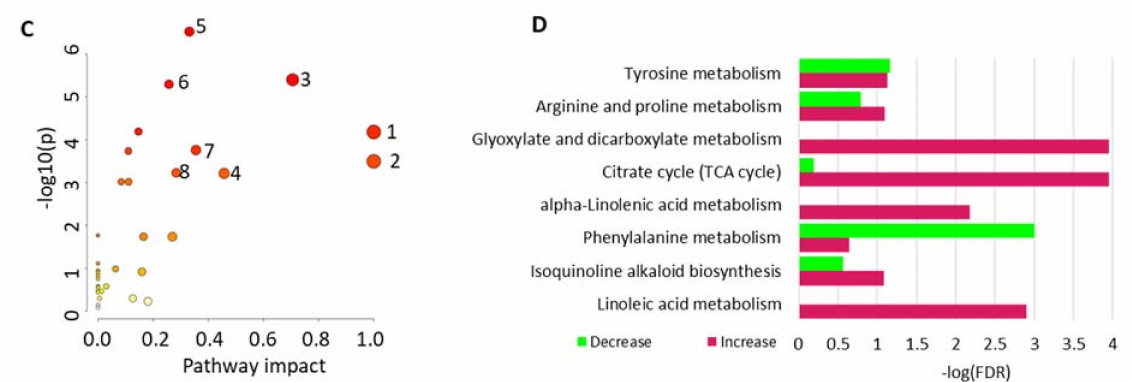
Figure 3. Metabolomics data analysis of WT and mpk4 mutant. ( A ) PCA analysis showing distinct separation of WT and the mpk4 . ( B ) Volcano plot. FC (fold change) = metabolite abundance in mpk4 /WT. ( C ) KEGG metabolic pathway impact analysis. 1: linoleic acid metabolism; 2: isoquinoline alkaloid biosynthesis; 3: phenylalanine metabolism; 4: alpha-linolenic acid metabolism; 5: citrate cycle; 6: glyoxylate and dicarboxylate metabolism; 7: arginine and proline metabolism; 8: tyrosine metabolism. The size of the dot indicates pathway impact factor; color of dots from light yellow to red indicates—log10 (p) from small to large. ( D ) KEGG enrichment analysis of eight significant pathways.